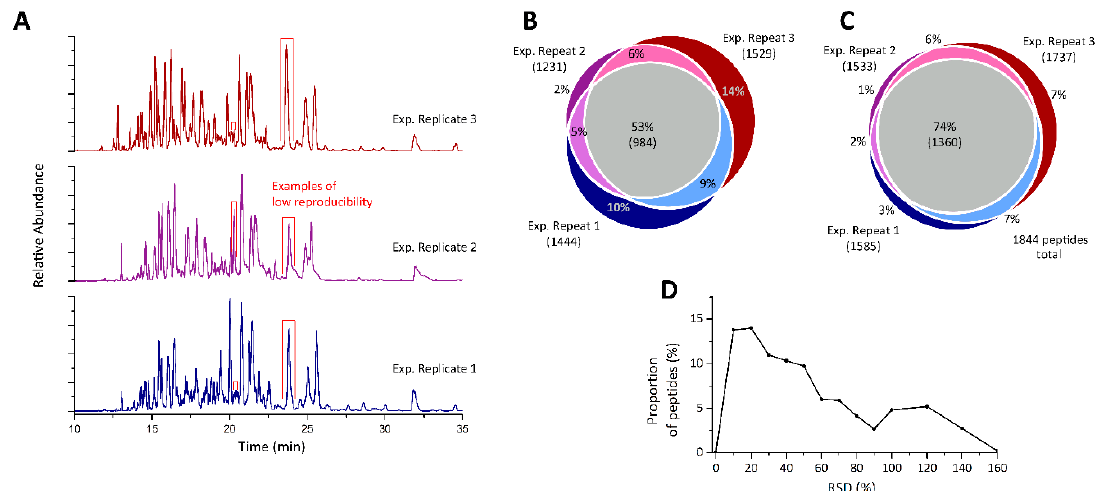
Figure 1. Analysis of SiO 2 NM protein corona enzymatically digested on-particle using trypsin in the presence of 100 mM ammonium bicarbonate (pH 8.0). ( A ) Base peak electropherograms of experimental replicates, red boxes indicate visual discrepancies between replicates. Venn diagrams of peptides ( B ) identified via MSMS and ( C ) detected as precursor mass in the three experimental replicates. ( D ) Reproducibility of peptide quantifications shown as a histogram of relative standard deviations (RSDs) calculated for each individual peptide.